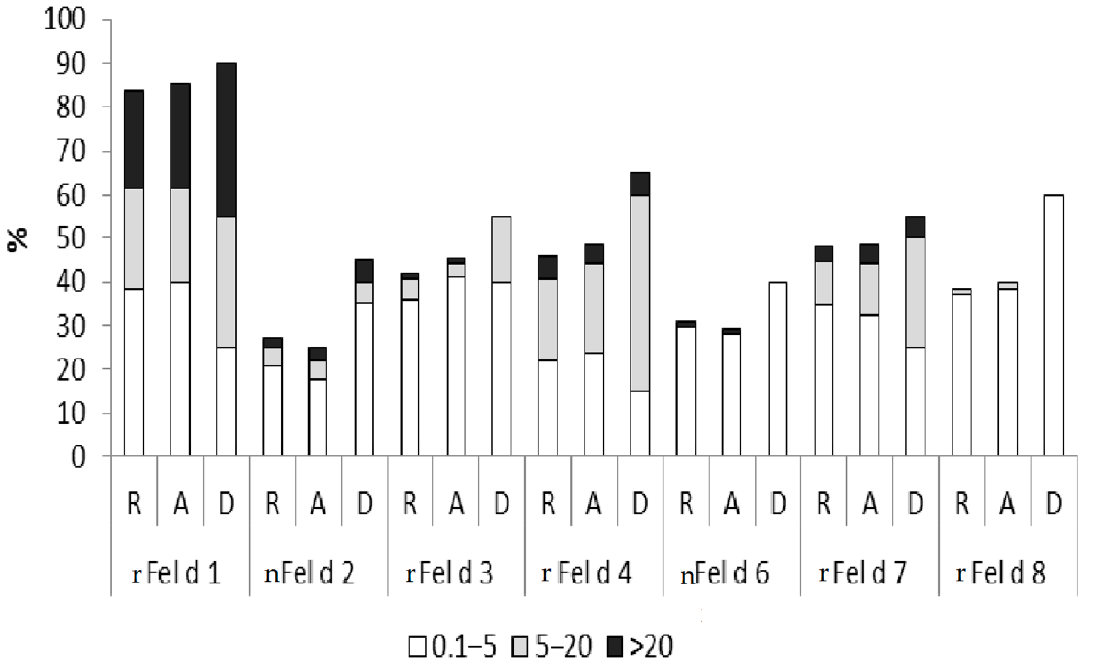
Figure 3. Prevalence and magnitude ( y -axis: percentage of sensitized patients, measured in kU A /L, as indicated at the bottom) of IgE sensitization to cat allergen molecules in cat allergic patients ( n = 73) with different symptoms (R: rhinitis; A: asthma; D: dermatitis).